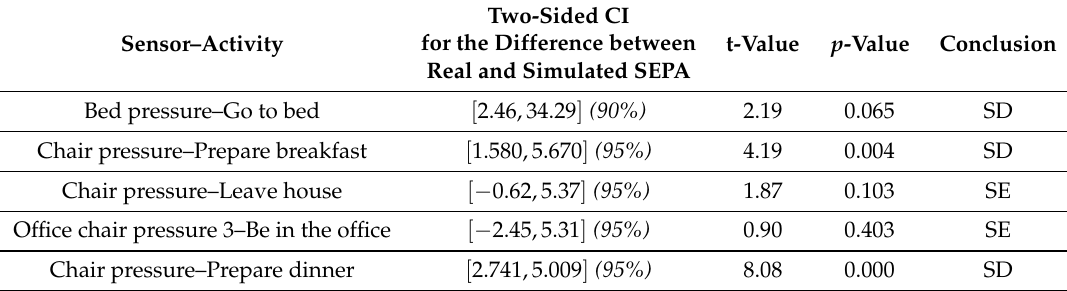
Table 5. Comparison between simulated and real pressure sensor events per